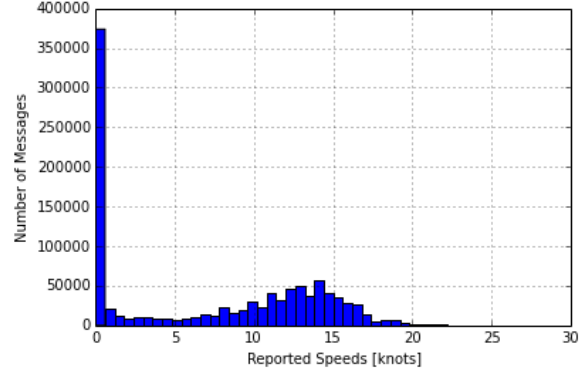
Figure 4. Histogram of reported vessel speeds.